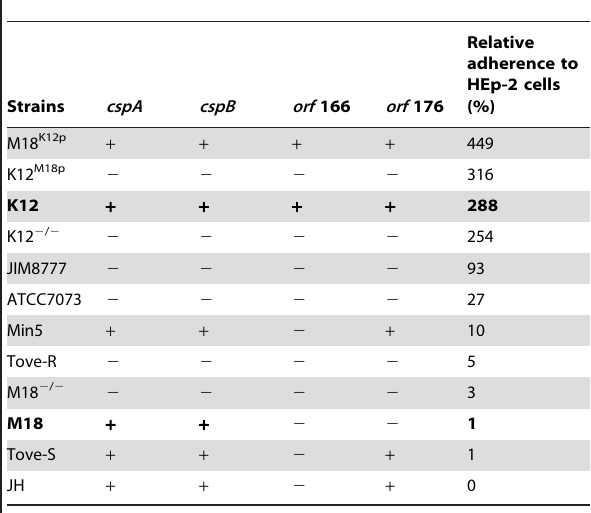
Simultaneous inhibition of indicator strain a and agar type tested